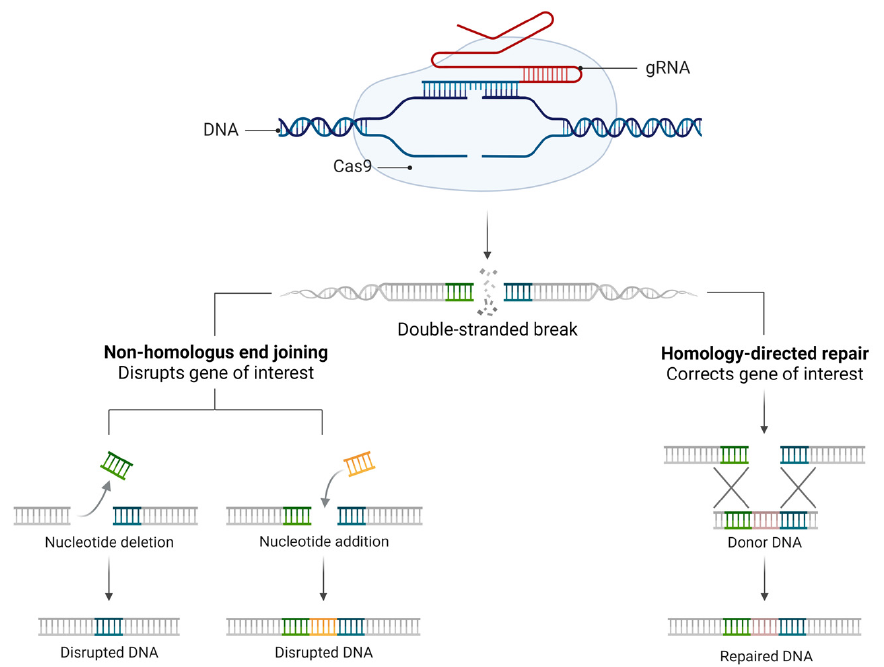
Figure 2. CRISPR repair mechanism. Classic CRISPR mechanism comprising the guide RNA (gRNA), target DNA, and endonuclease (Cas9), which promotes DNA cleavage by DSBs induced by Cas9. DSBs can be repaired by two main mechanisms: the NHEJ mechanism, where the ends of the strands come together (this is subject to unwanted insertions or deletions), or by the HDR pathway, which uses the recombination donor DNA templates to reconstitute the